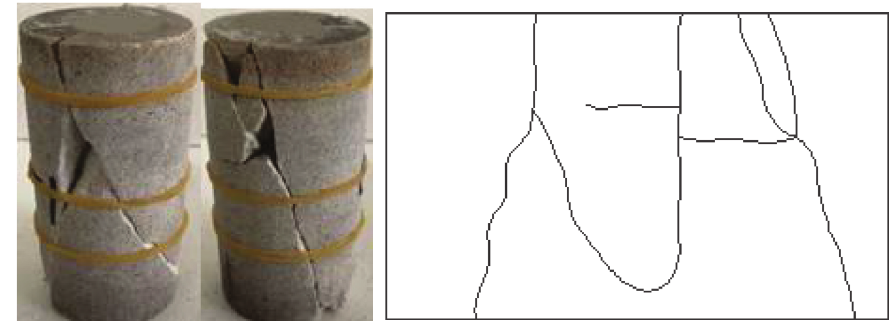
Figure 15: Failure diagram and crack diagram of a typical specimen. (a) Fracture diagram and fracture sketch of a typical rock sample in the conventional triaxial compression test. (b) Typical fracture diagram and fracture sketch of the unloading damaged rock